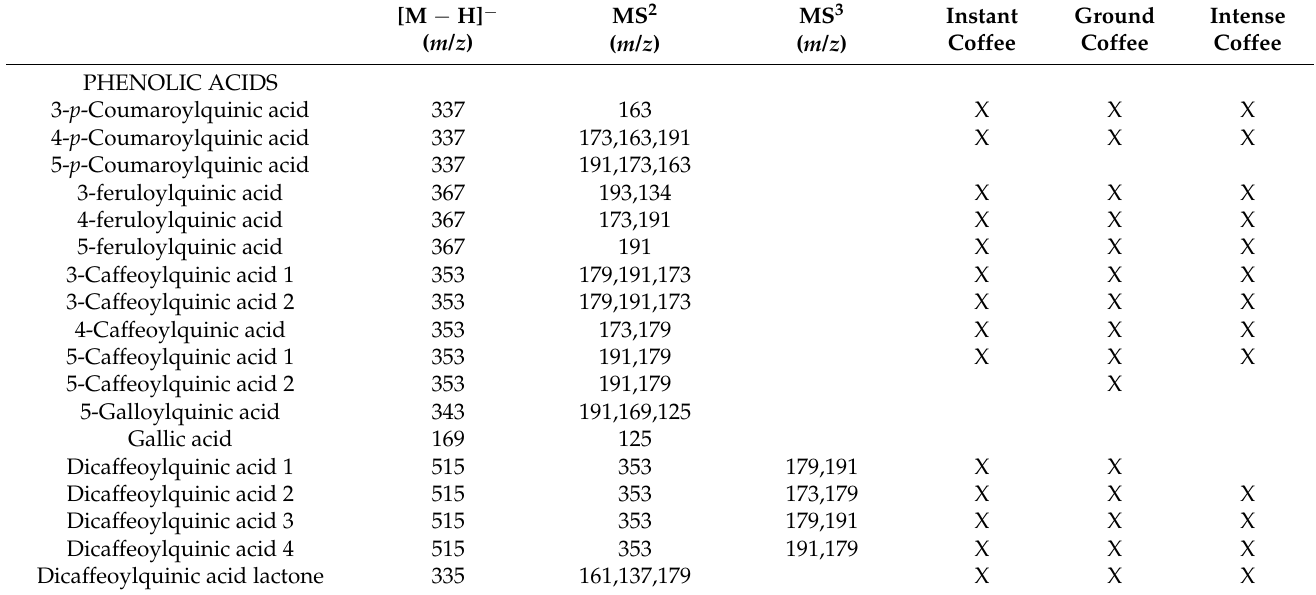
Table 2. Identification of phenolic compounds in coffees in negative ionization with HPLC-MS and MS 2 /MS 3